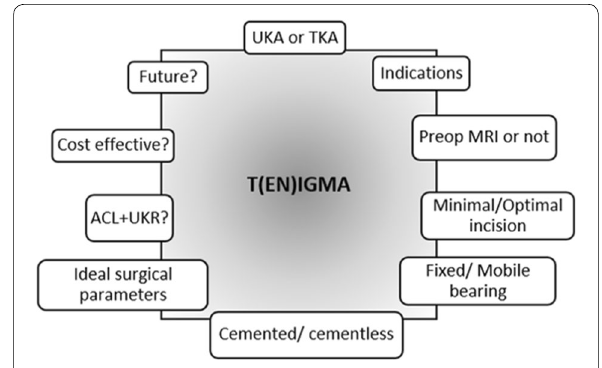
Fig. 1 Ten Enigmas (TENIGMAs) of